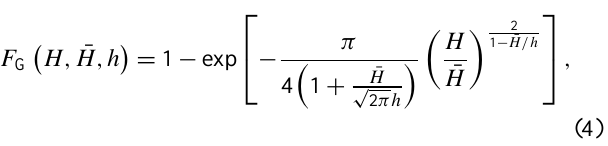
wake; red dashed line corresponds to the Rayleigh distribution to the Rayleigh distribution (  =0.12 m), black solid line corresponds to the Weibull distribution ( σ = 0 . 12m), black solid line corresponds to the Weibull distribu-